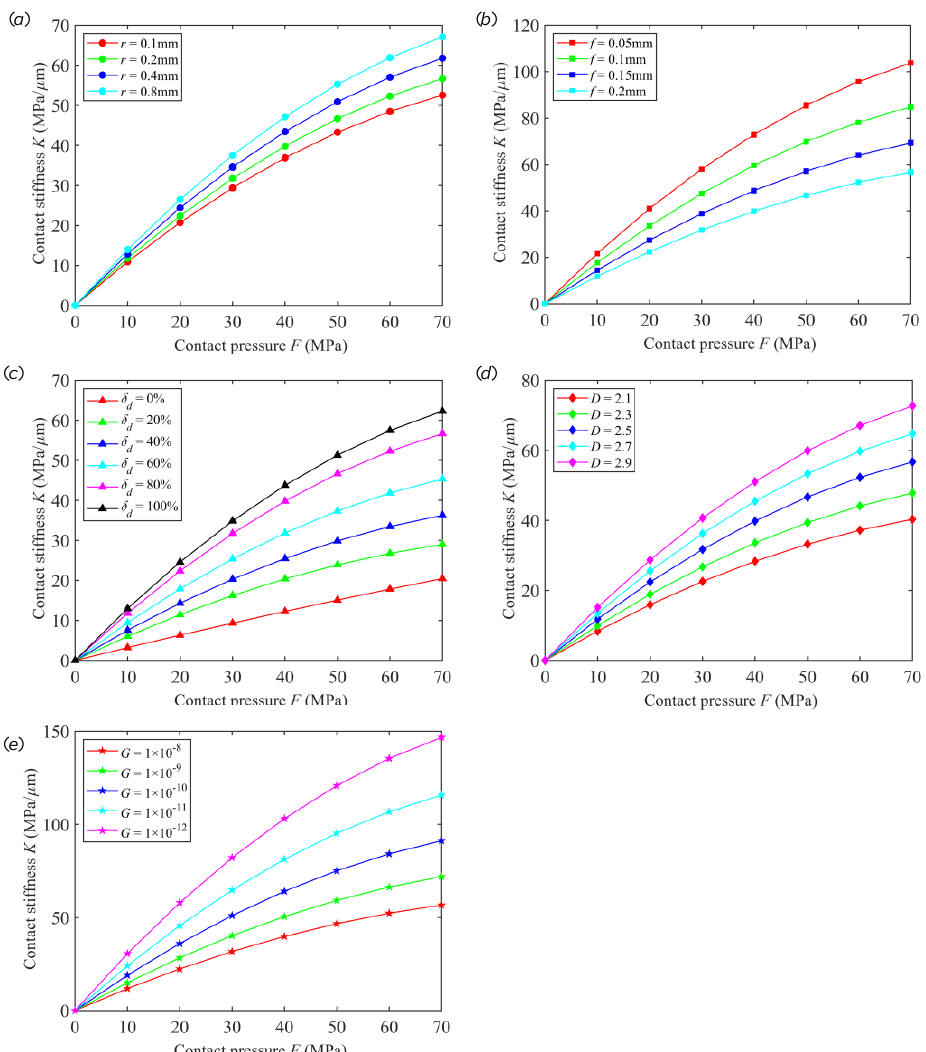
Figure 7. Comparison results for normal contact stiffness. ( a ) Different arc radii of turning tools; ( b ) Different turning feed rates; ( c ) Different grinding depths; ( d ) Different fractal dimensions; ( e ) Different scale coefficients.